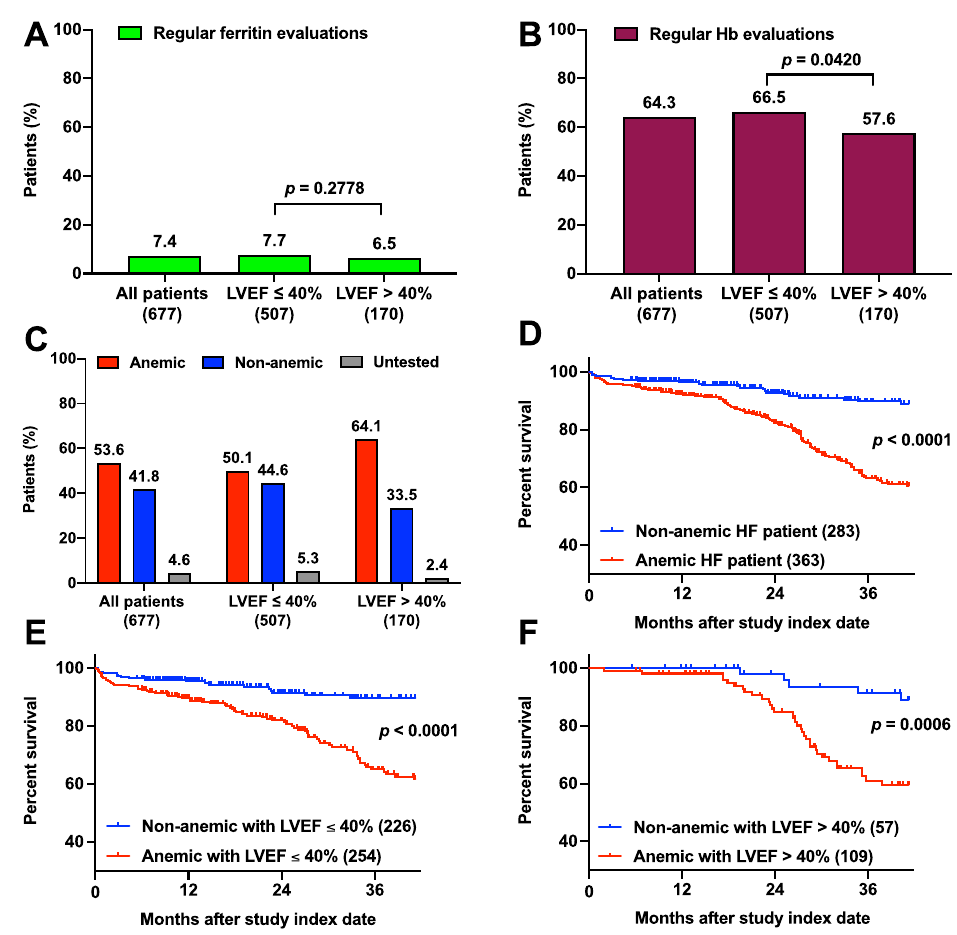
Figure 2. Frequency of evaluation, prevalence, and survival among patients with heart failure with or without anemia. In the ID audit, we deemed patients with two records of iron or Hb levels within any 13 consecutive months or one record during an observation period of fewer than 12 months to have had regular iron or Hb evaluations. Among the 677 patients in the cohort, ( A ) 7.4% received regular iron evaluations, and ( B ) 64.3% received regular Hb evaluations. The patients were grouped by LVEF at the index date of the study . ( C ) The prevalence of anemia was 53.6% in the overall study cohort and 50.1% and 64.1% in the LVEF of ≤ 40% and LVEF of > 40% groups, respectively. We then obtained patients’ dates of death during the observation period from the Integrated Medical Database of National Taiwan University Hospital and used the Kaplan–Meier survival curves and a log-rank test to analyze the differences in survival between the patients with and without anemia in ( D ) the study cohort, ( E ) the group of patients with LVEFs of ≤ 40% at the index date, and ( F ) the group of patients with LVEFs of > 40% at the index date. Hb: hemoglobin; ID: iron deficiency; LVEF: left ventricular ejection